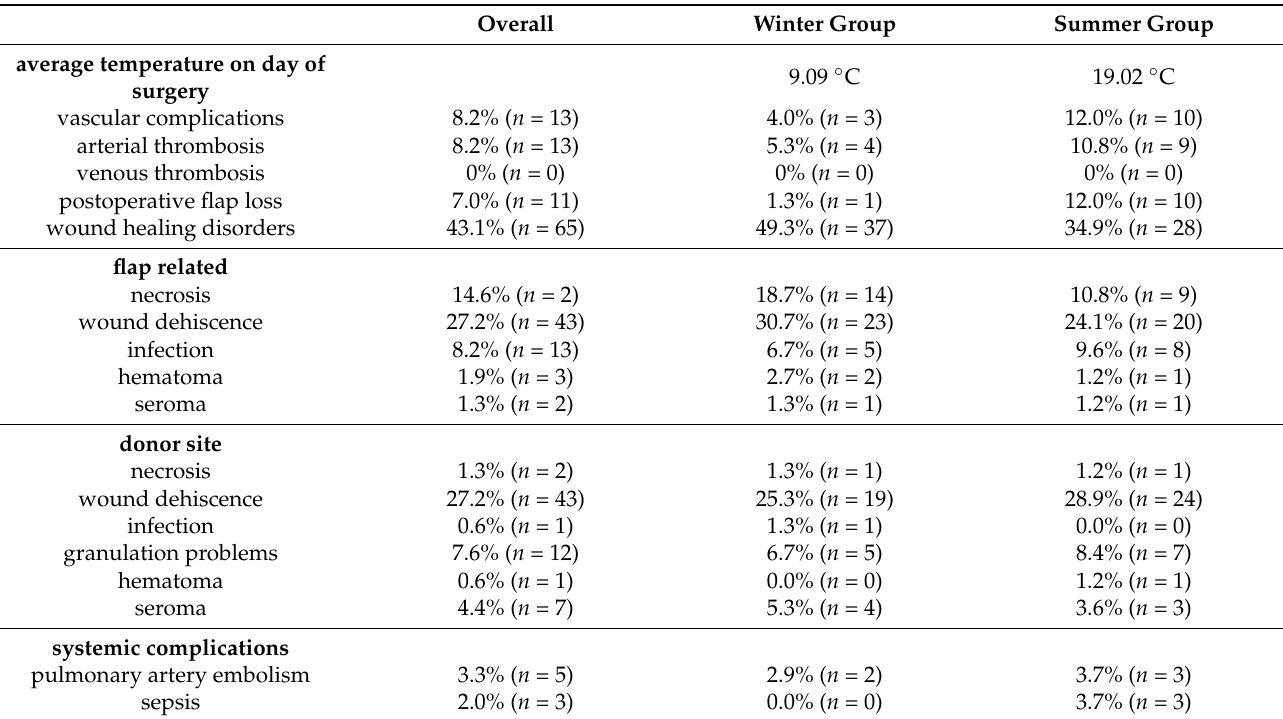
Table 2. Variance homogenity was present for the variables of age ( p = 0.677 > 0.05),